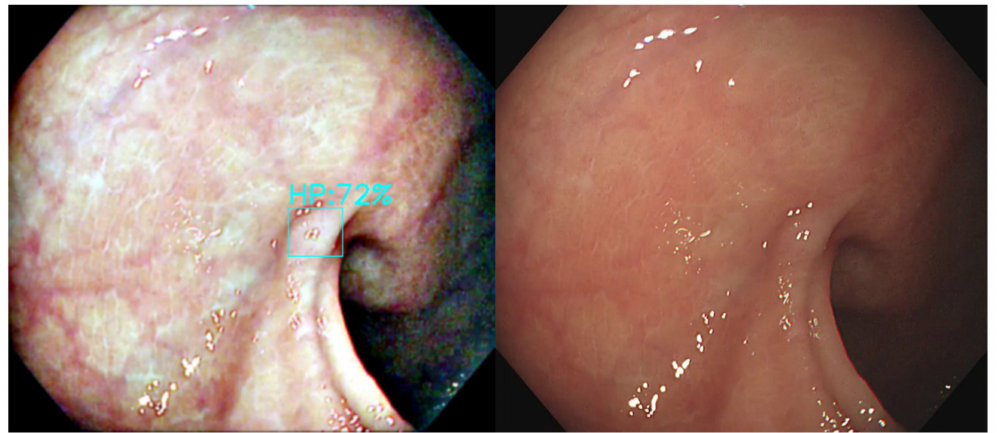
Figure 13. The correct results of MSRCR vs. the misclassified polyp of original image. (( Left ): MSRCR, ( Right ): Original).